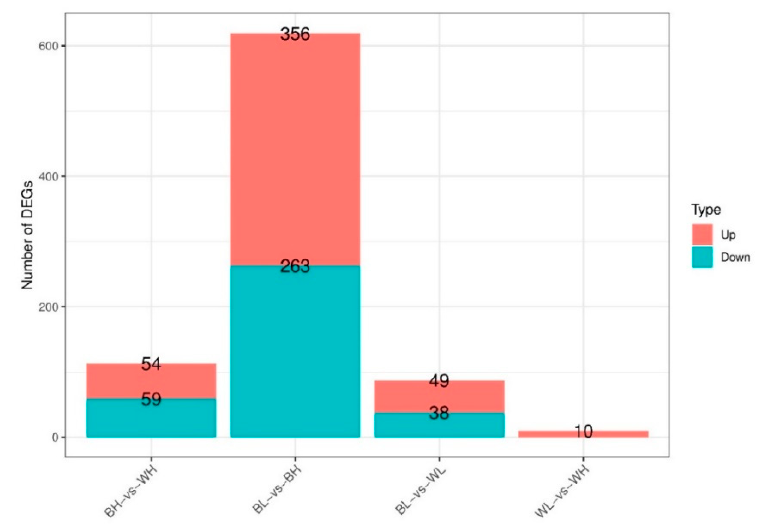
Figure 1. Statistic of differentially expressed genes (DEGs).